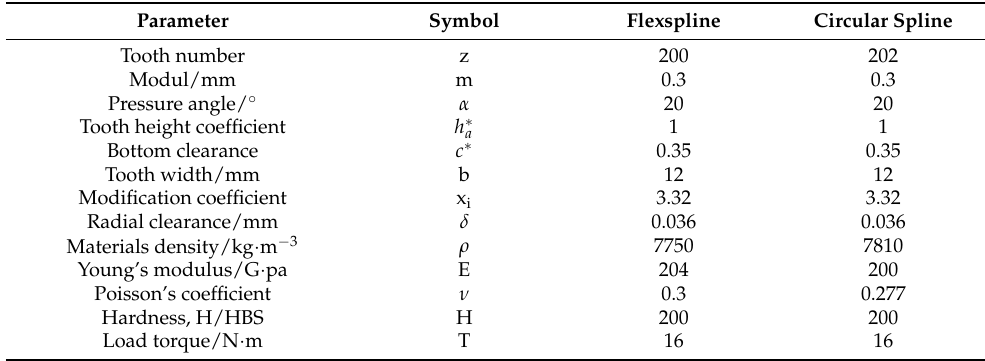
Table 1. Adopted parameter values.